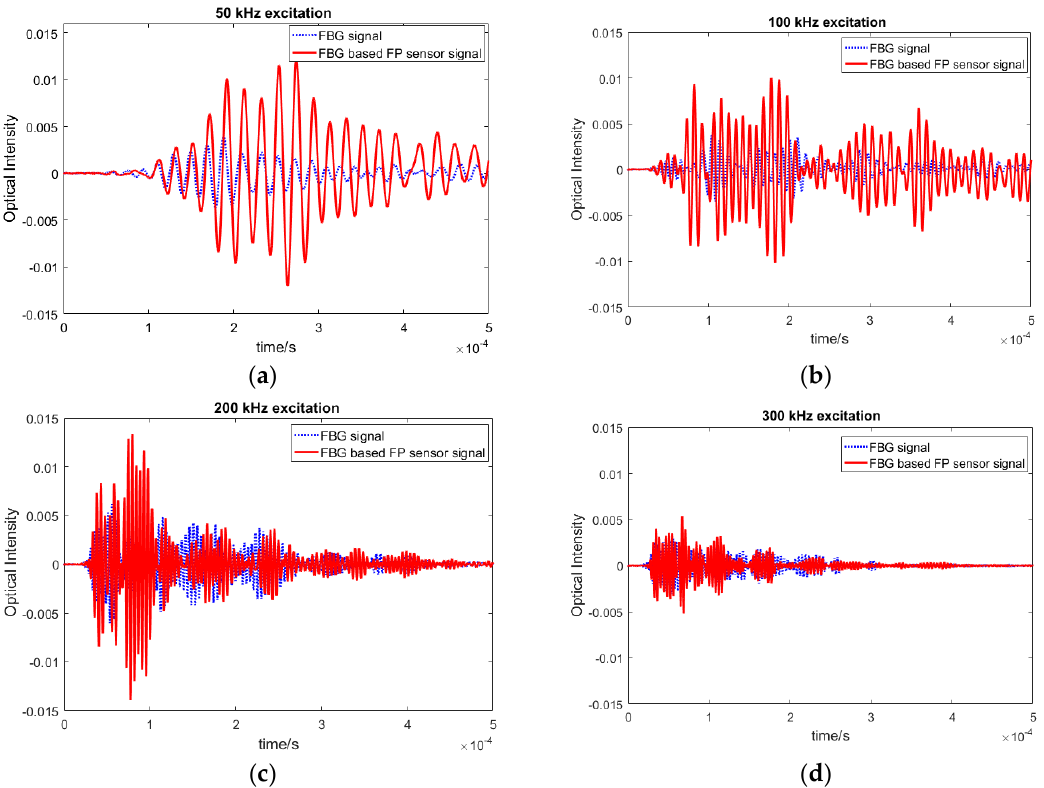
Figure 14. Comparison between FBG and FBG-based FP guided wave signals at ( a ) 50 kHz, ( b ) 100 kHz,